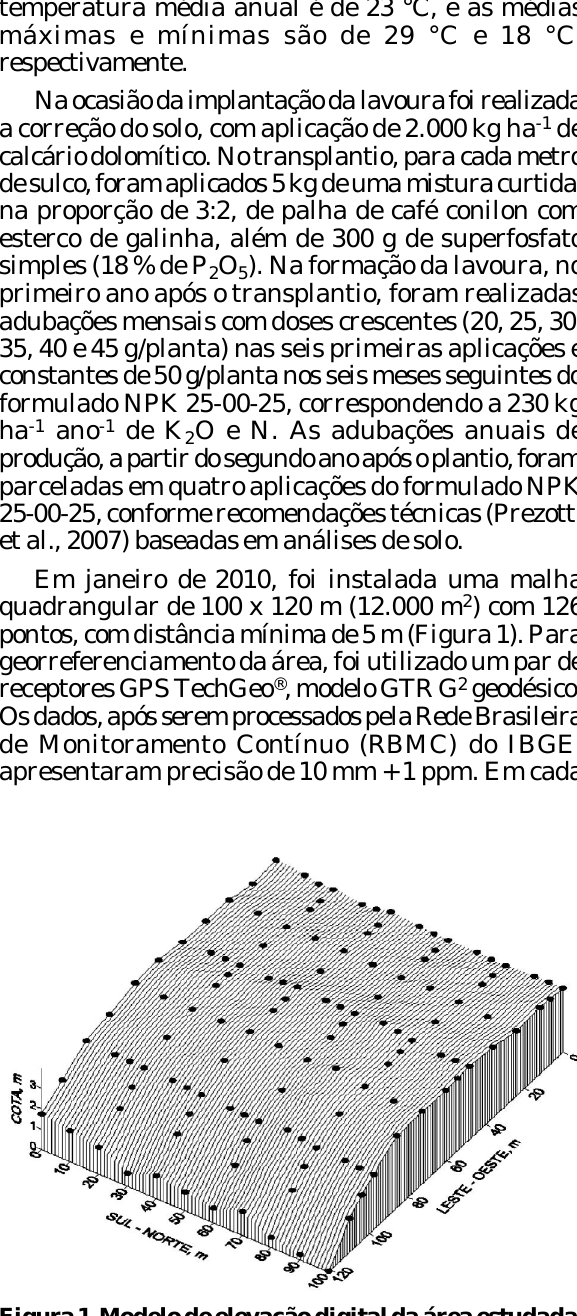
Figura 1. Modelo de elevação digital da área estudada, com os respectivos locais de